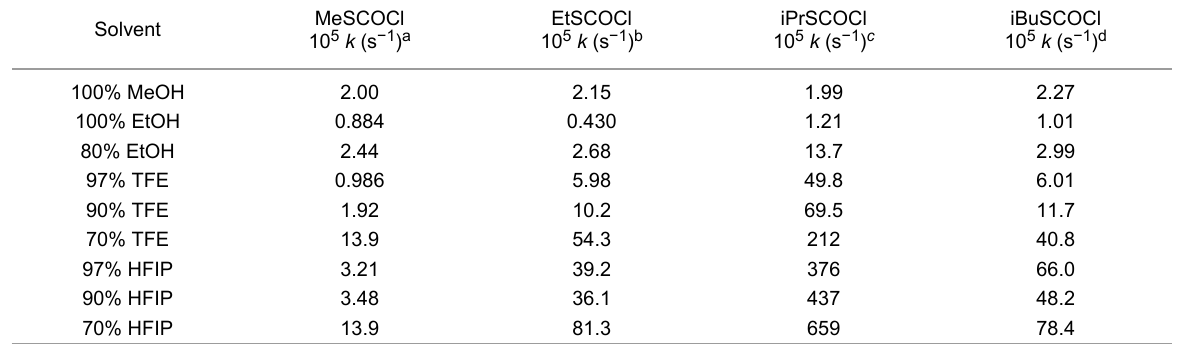
Table 5: A comparison of the rates of solvolysis of MeSCOCl, EtSCOCl, iPrSCOCl, and iBuSCOCl, in selected common solvents at 25.0 °C.